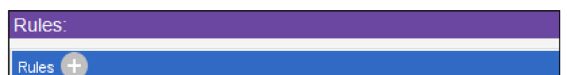
Above is the key material and ontology implementation after the ontology revise and validation. The supplemen- tary material will lead reviewers / independent researcher to reproduce the result.